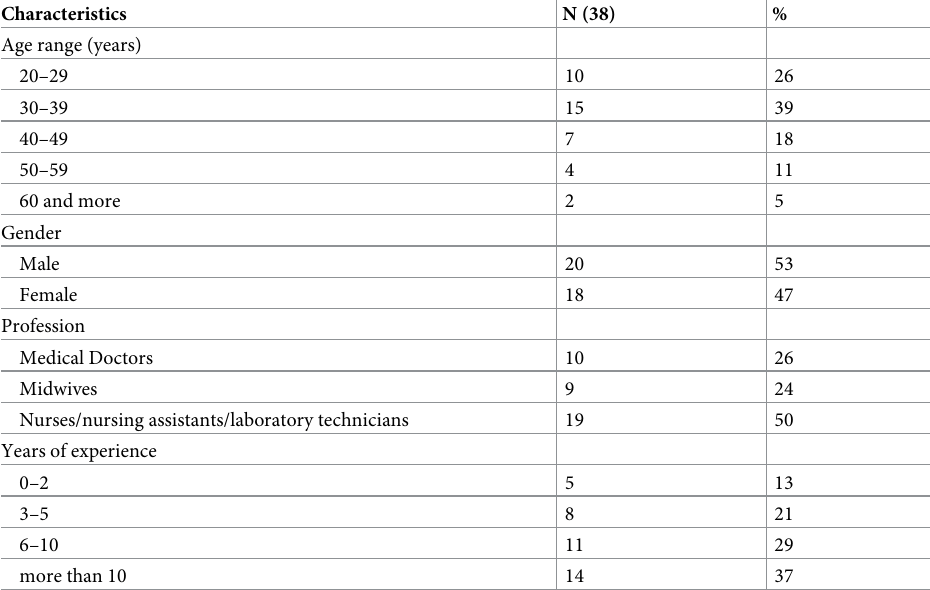
Table 2. Study population and